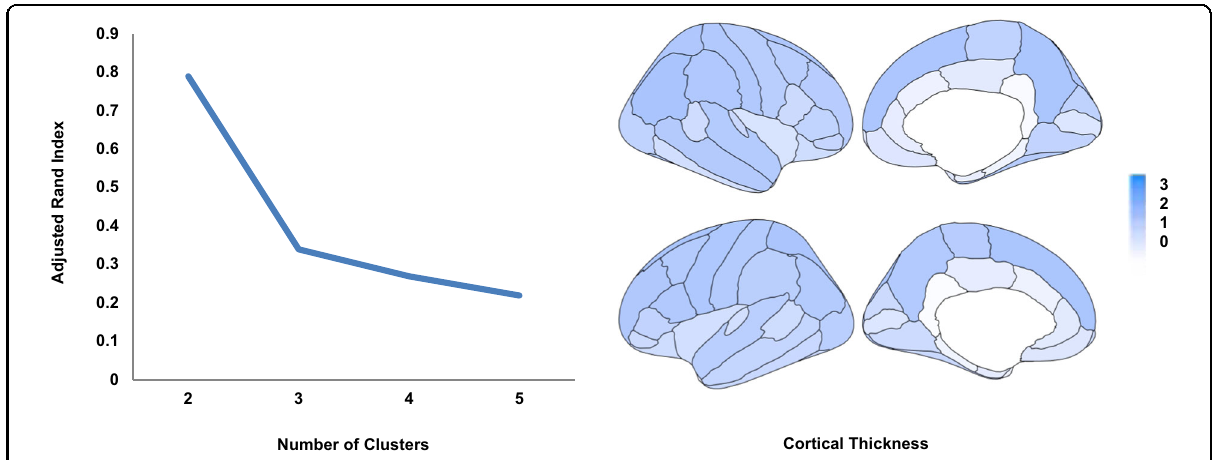
Fig. 2 Patient clusters derived through heterogeneity through discriminative analysis (HYDRA). Left: HYDRA identi fi ed two clusters of patients based on the adjusted Rand index (ARI). This is shown as a clear peak in ARI values for the 2-cluster solution. Right: The two clusters differed in global and regional cortical thickness; the Cohen ’ s d of these regional differences is mapped onto the corresponding cortical regions (additional details in Supplemental